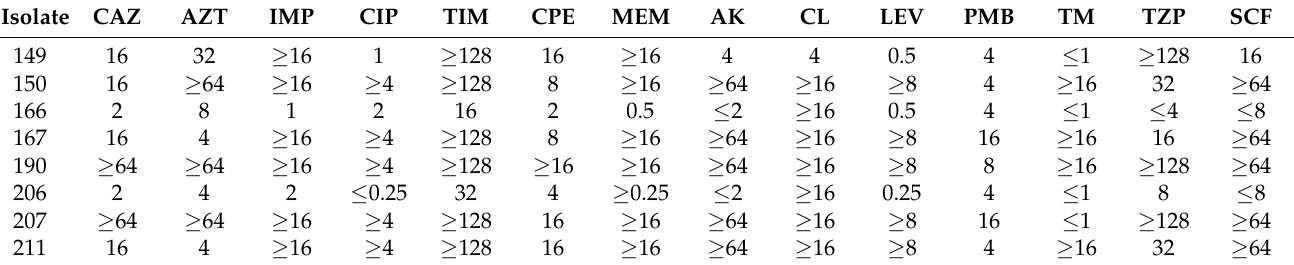
Table 2. Antimicrobial susceptibilities of the polymyxin-resistant P. aeruginosa isolates (MICs, µ g/mL).